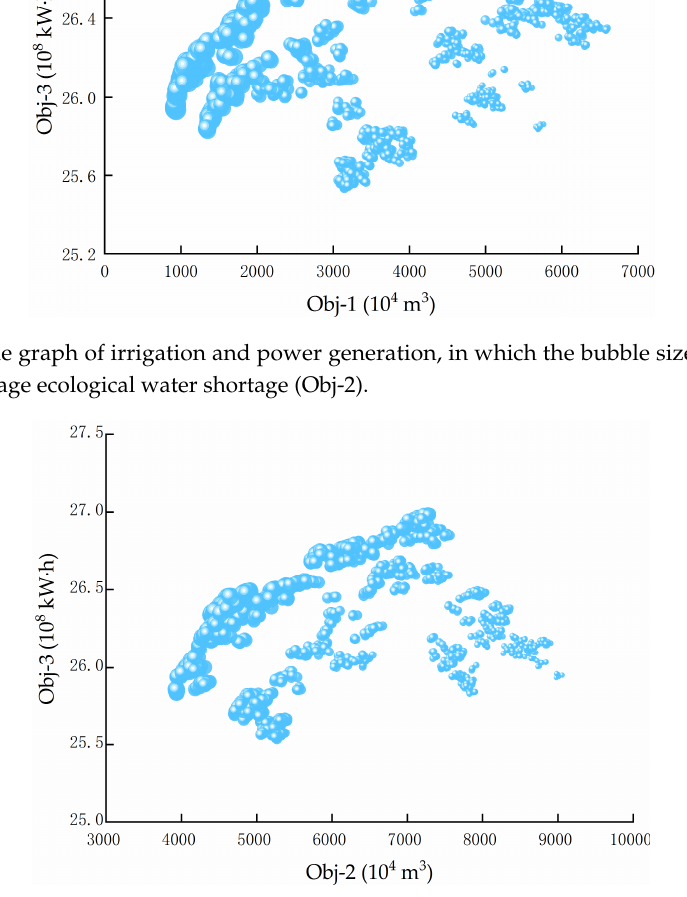
Figure 6. Bubble graph of ecology and power generation, in which the bubble size represents the multi-year average irrigation water shortage